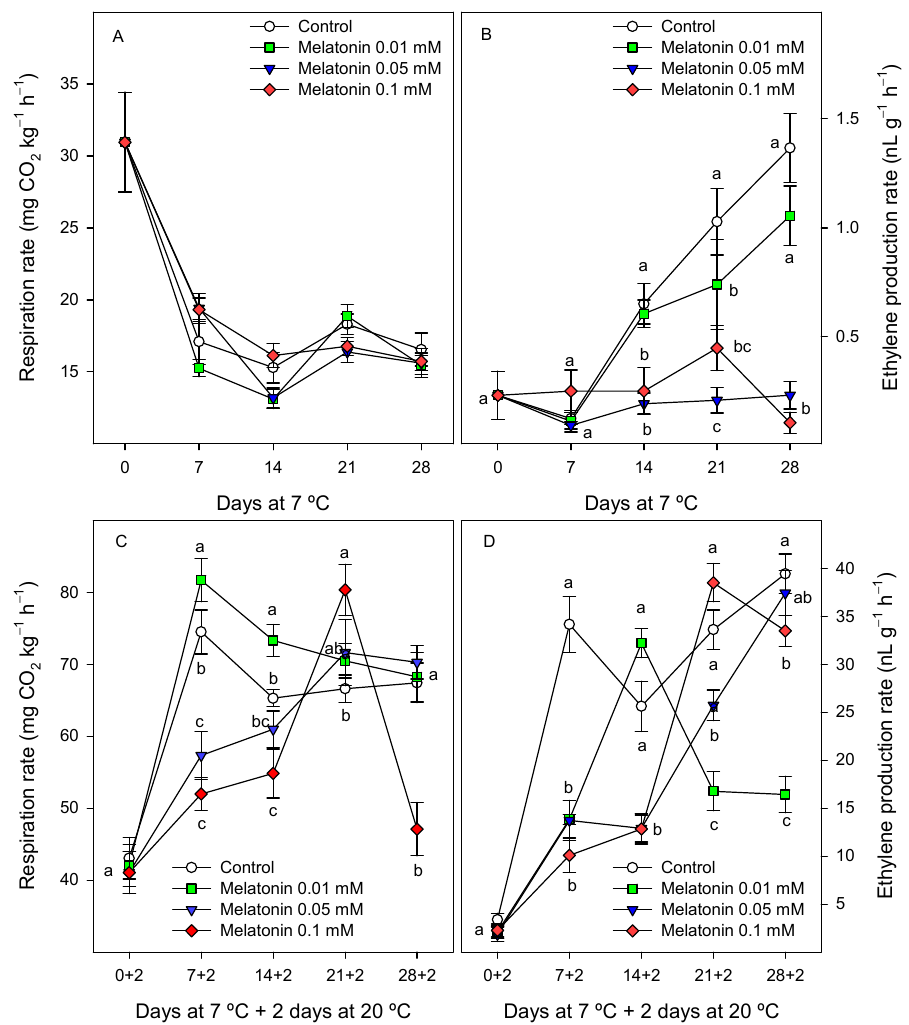
Figure 6. Respiration rate ( A , C ) and ethylene production ( B , D ) in control and 0.01, 0.05 and 0.1 mM melatonin-treated fruit during storage at 7 °C ( A , B , for respiration and ethylene, respectively) and subsequent shelf life at 20 °C ( C , D , for respiration and ethylene, respectively). Data are the mean ± SE of three replicates. Different letters show significant differences ( p < 0.05) among treatments for each sampling date.